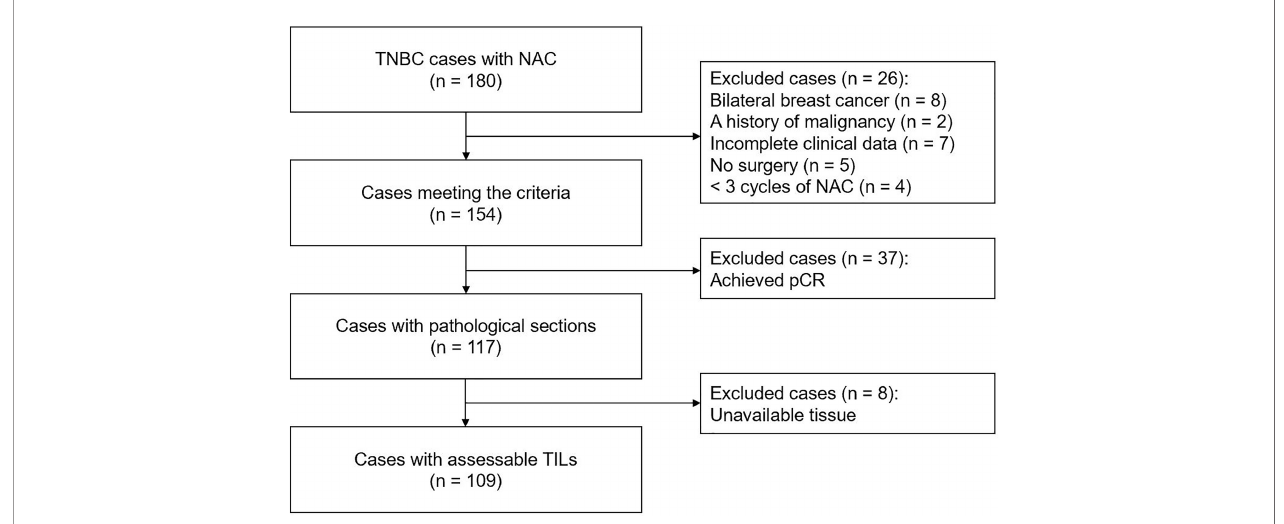
FIGURE 1 | Flowchart of patient selection in present study. TNBC, triple-negative breast cancer; NAC, neoadjuvant chemotherapy; pCR, pathological complete response; TILs, tumor-in fi ltrating